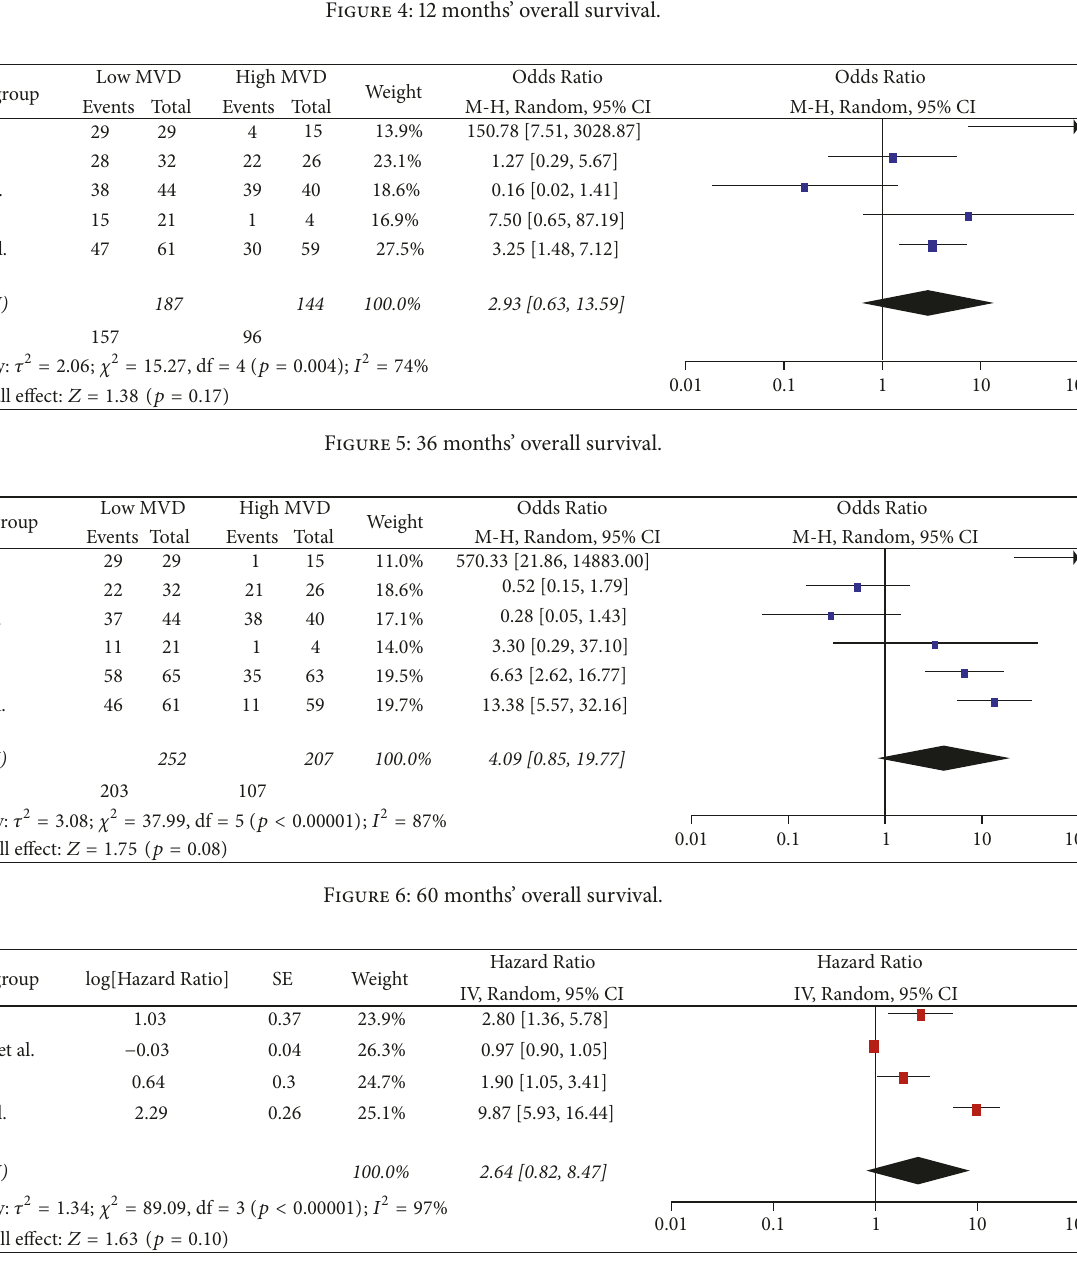
Figure 7: Hazard Ratio of disease-free